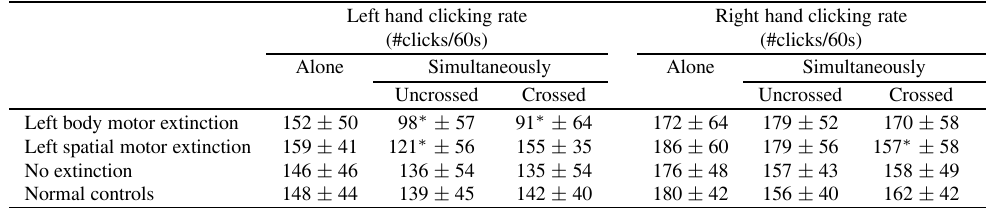
Table 2 Clicking rates for participants in each group in each